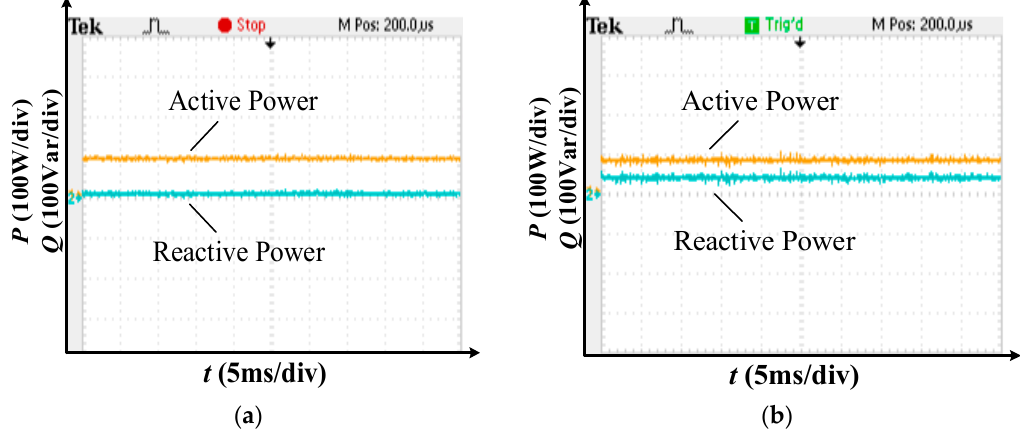
Figure 19. Experimental waveforms of the given power control strategy for SPEER: ( a ) the active power is 100 W; the reactive power is 0 Var; ( b ) the active power is 80 W; the reactive power is 50 Var.